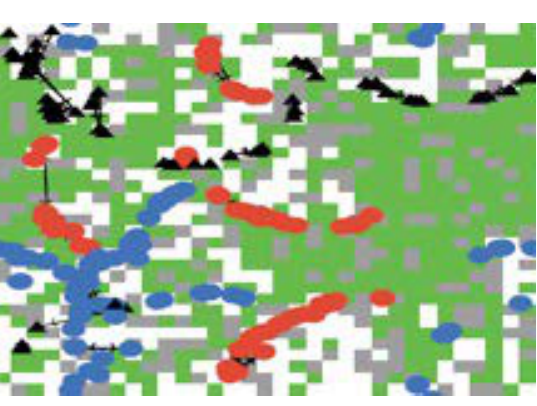
= 96). The model is stopped at 16 ticks. Active